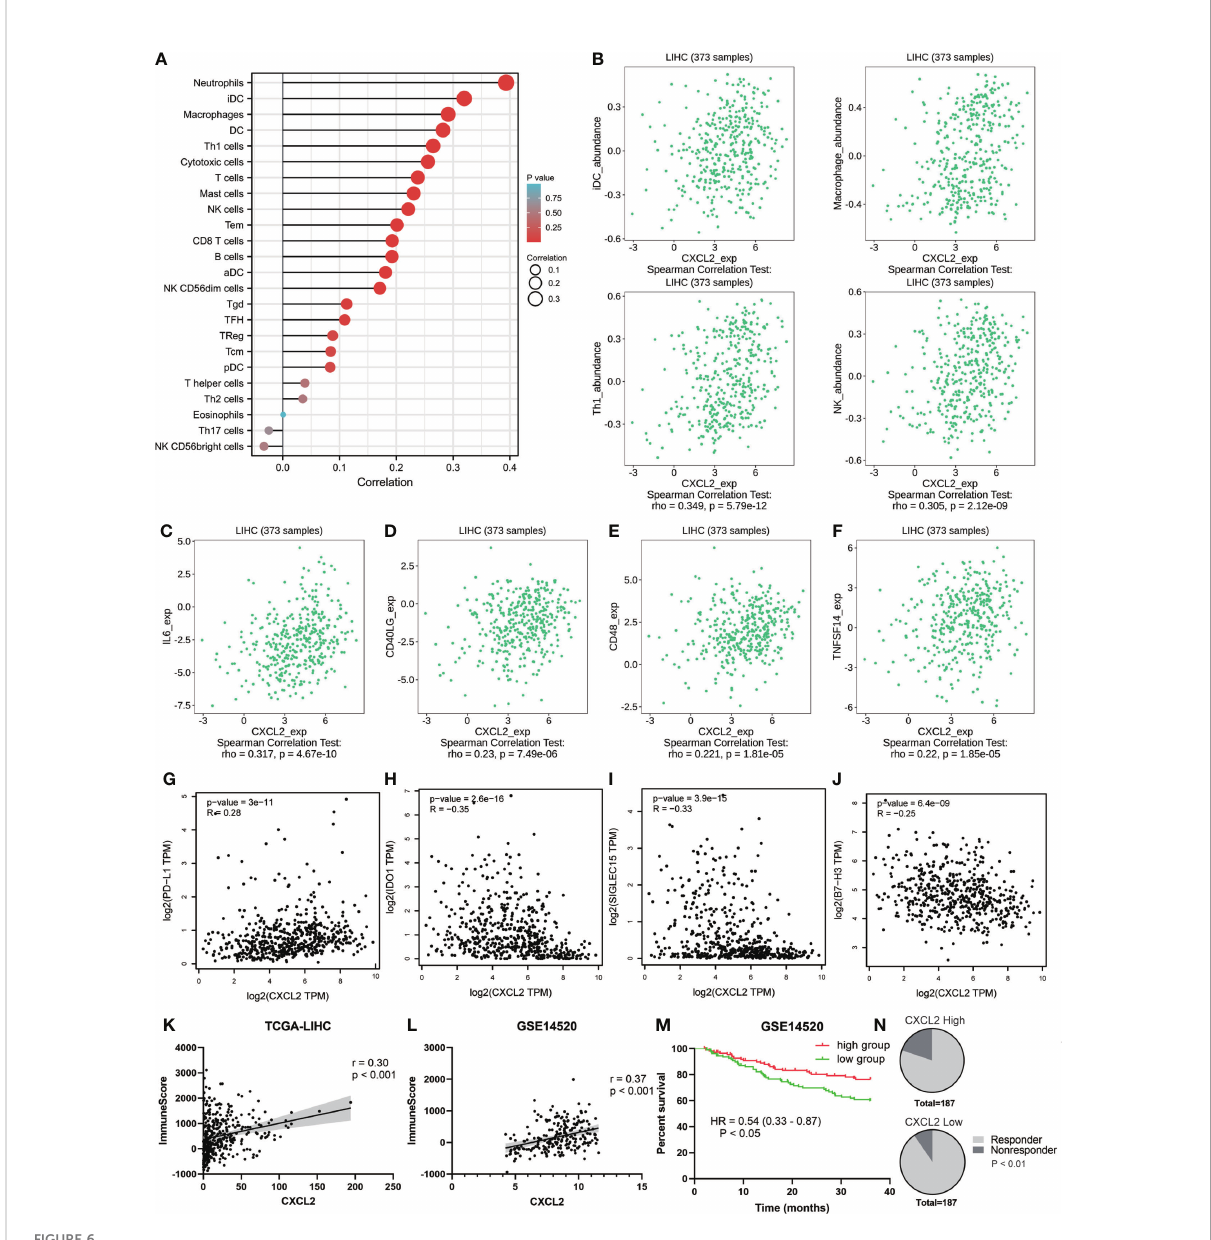
FIGURE 6 The role of CXCL2 in immune microenvironment of HCC. (A) Lollipop diagram exhibiting tumor-in fi ltrating immune cells associated with CXCL2 by Xiantao tool. (B) Scatter plots cross-validating the associations between CXCL2 expression and several TILs, including iDC, macrophage, Th1, and NK cells. (C-F) Positive correlations between CXCL2 expression and several immunostimulators, including IL-16, CD40LG, CD48, and TNFSF14. (G-J) Association between CXCL2 expression and immune checkpoints. (K, L) Association between CXCL2 expression and immune score in TCGA-LIHC cohort and GSE14520 evaluated by ESTIMATE algorithm. (M) Kaplan-Meier survival curves showing 3-year overall survival based on immune score in GSE14520 dataset. (N) The predicted response rate of the CXCL2 high expression group was lower than that of the CXCL2 low expression